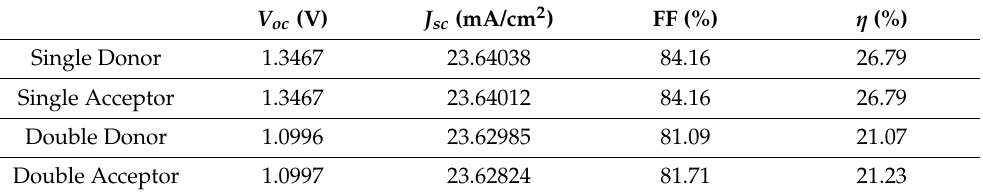
Table 2. Defect state effect on output characteristics of solar cell at trap density of 10 17 cm − 3 .